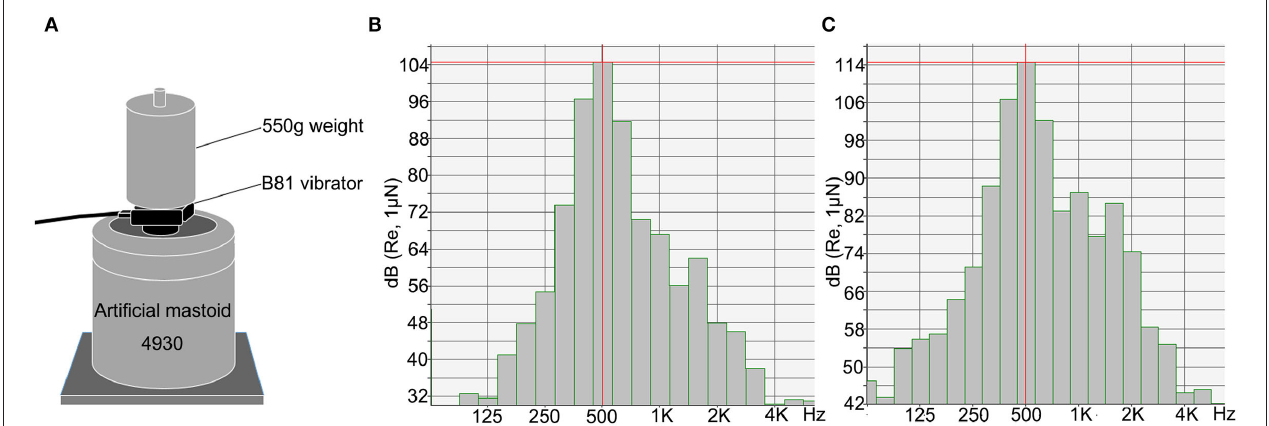
FIGURE 1 | The Radioear B81 bone vibrator was calibrated using an artificial mastoid. (A) Artificial mastoid 4930 (Brüel & Kjær, Denmark) was used to calibrate the B81 bone vibrator. A constant force was maintained by adding a 550g weight to the artificial mastoid when calibrating. (B,C) The spectra show energy distribution of 500Hz tone burst of the B81 bone vibrator at the output of 119.5 dB peFL (stimuli were delivered at 50 dB nHL) (B) and 129.5 dB peFL (stimuli were delivered at 60 dB nHL) (C) . The central energy is at 500Hz.